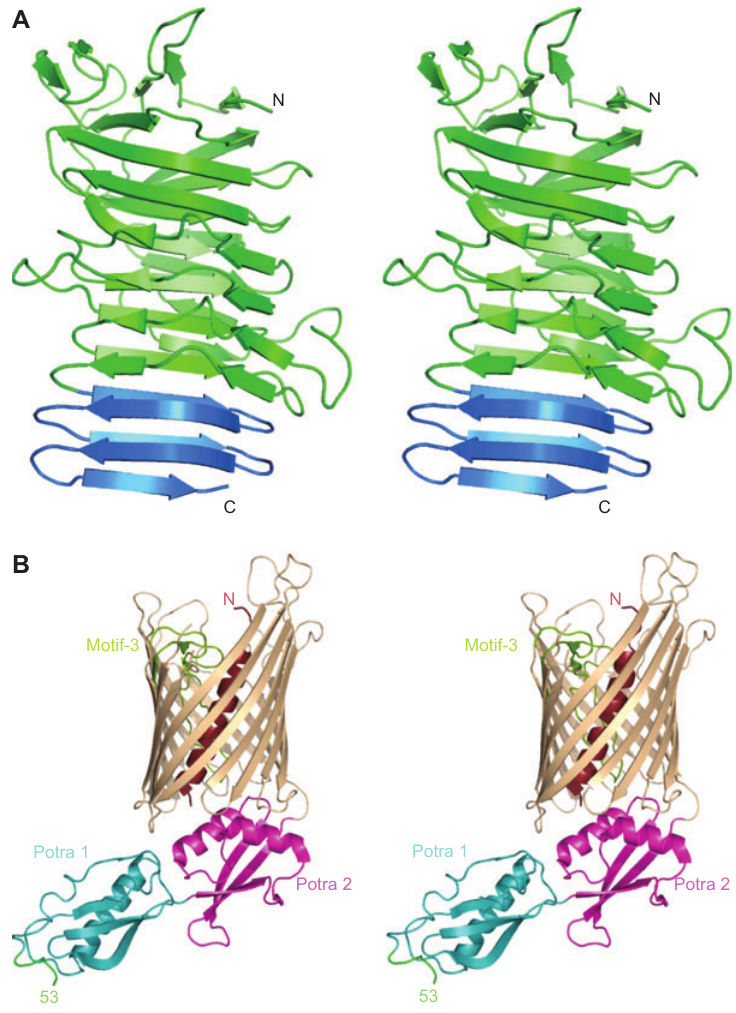
Figure 4 C α traces of the two-partner system FHA and its transporter FhaC. (A) The N-terminal region of FHA, expressed as a truncated fragment of 304 residues (47) . The fi rst 252 residues (shown in green) form the TPS domain, essential for secretion. The remainder of this fragment (shown in blue) is part of a repeat region called R1. Interactions have been shown between the POTRA domains of FhaC and the TPS and R1 regions of FHA (48) . (B) FhaC includes a 16-stranded β -barrel carrying a long α -helix called H1 (shown in brown) and two POTRA domains attached at the N-terminus. Residues 1 – 30 form the helix, which lies inside the barrel, alongside Motif 3 (shown in green), which forms a long loop. Residues 31 – 52 are not visible in the electron density map. The POTRA domains and Motif 3, but not H1, are required for secretion of FHA. Although Motif 3 lies deep inside the barrel in the crystal structure, it becomes accessible to proteolytic attack in the course of FHA secretion. The model shown is PDB entry 2QDZ (46)